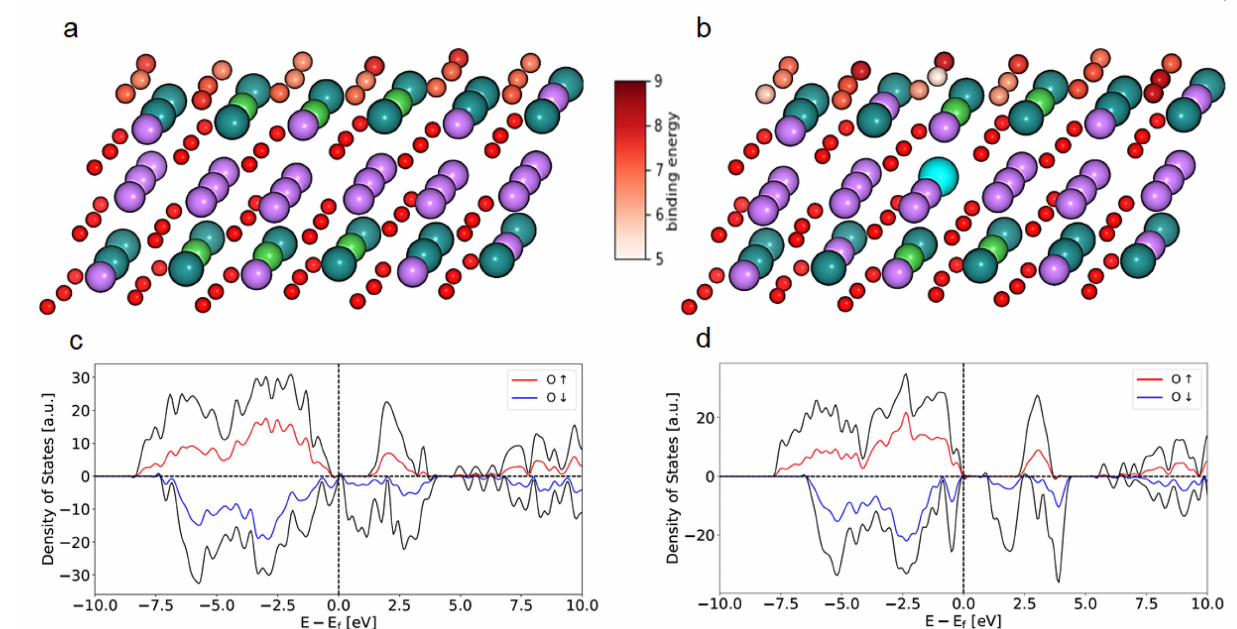
Figure 4. Effect of Na doping on the BE and projected DOS of O 2p of surface oxygen atoms. ( a ) 1 . ( b ) 2 . Atoms color code- O: red, Ru: dark green, Ni: light green, Na: light blue, Li: purple. The oxygen atoms at the top layer are shaded based on their binding energy. Total DOS (black line) and projected DOS (spin up: red line and spin down: blue line) of p orbitals of oxygen: ( c ) 1 . ( d ) 2